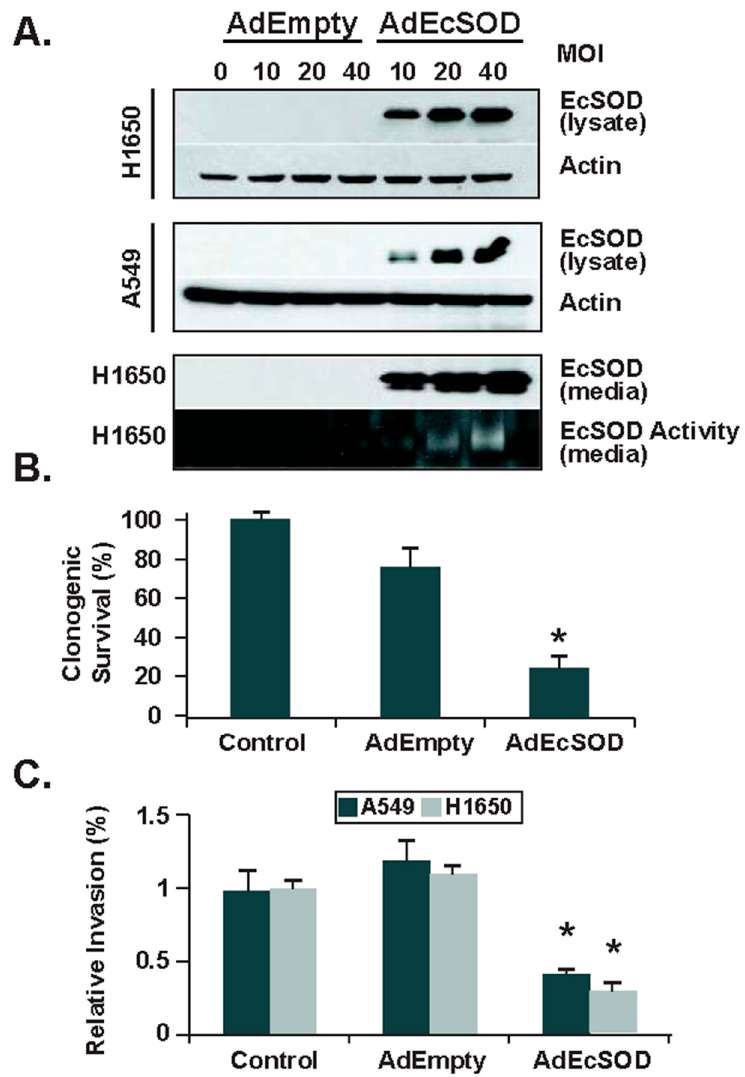
Figure 4. Forced re-expression of EcSOD reduced the clonogenic capacity and invasive potential of human lung cancer cells. ( A ) Following adenovirus transduction of EcSOD (AdEcSOD) in lung cancer cell lines, Western blot shows increased expression of EcSOD in both cell lysates and in culture media. An activity gel (bottom panel) shows that EcSOD was secreted and was catalytically active in the adenovirus infected H1650 cells. Empty vector infection did not induce EcSOD expression.